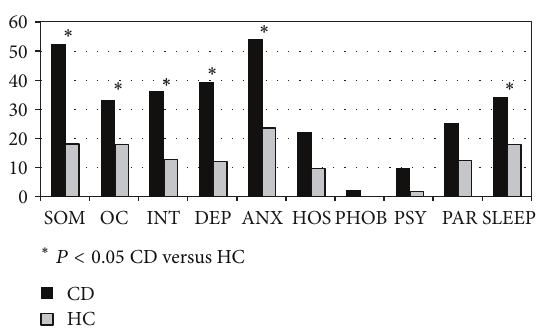
Figure 2: Percentages of pathological SLC-90 subscale scores in celiac disease (CD) patients (black) and healthy controls (HC, grey). Data are expressed as percentages and 𝑃 value (Student’s 𝑡 -test for unpaired